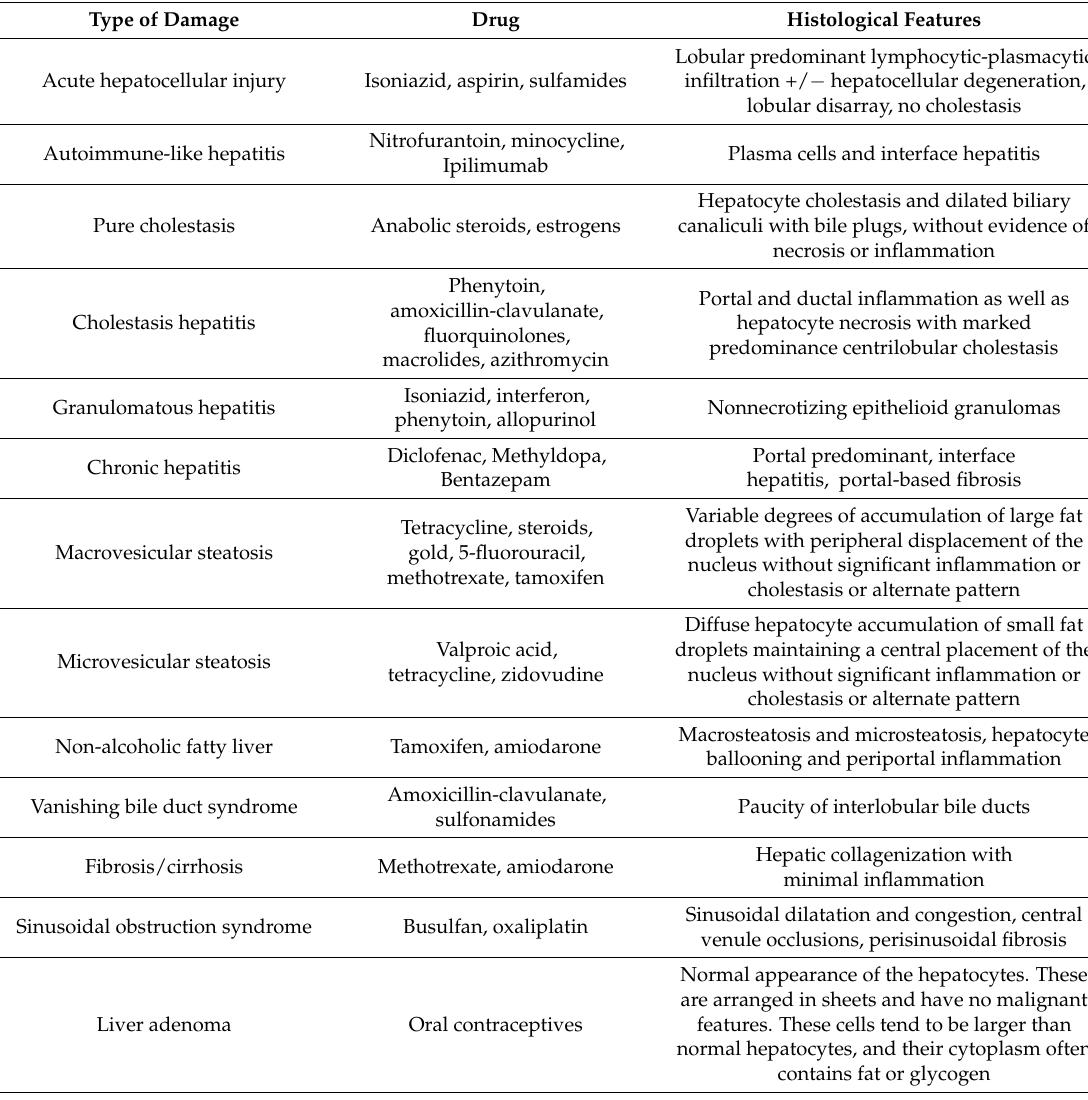
Table 4. Clinicopathological Patterns of